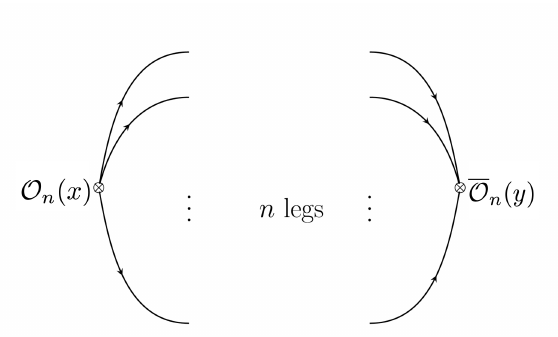
Figure 1 . Graphical representation of the chiral and anti-chiral operators O n ( x ) and O n ( y ) . The outgoing lines represent the chiral field ϕ while the incoming lines represent the anti-chiral field ϕ .